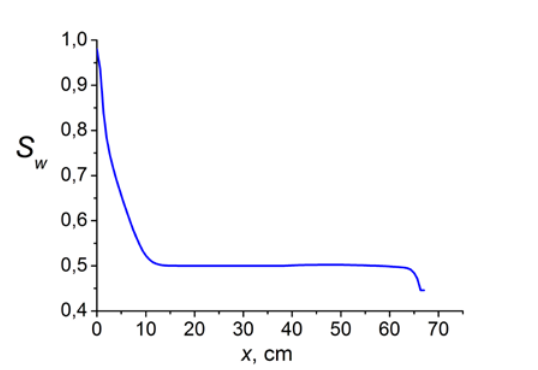
Fig. 8. The water saturation in the heatpipe effect problem.